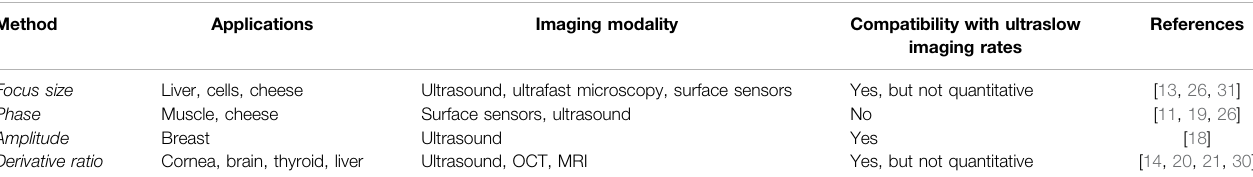
TABLE 1 | Summary of the methods and applications based on noise correlation